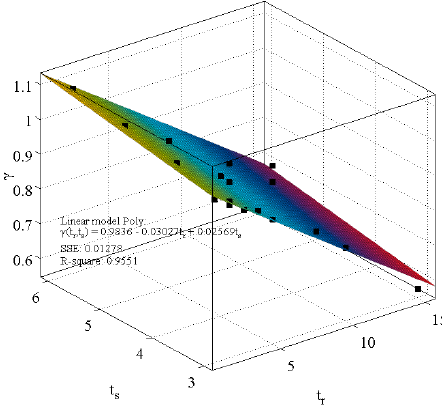
Figure 22. The γ relationship based on the regression